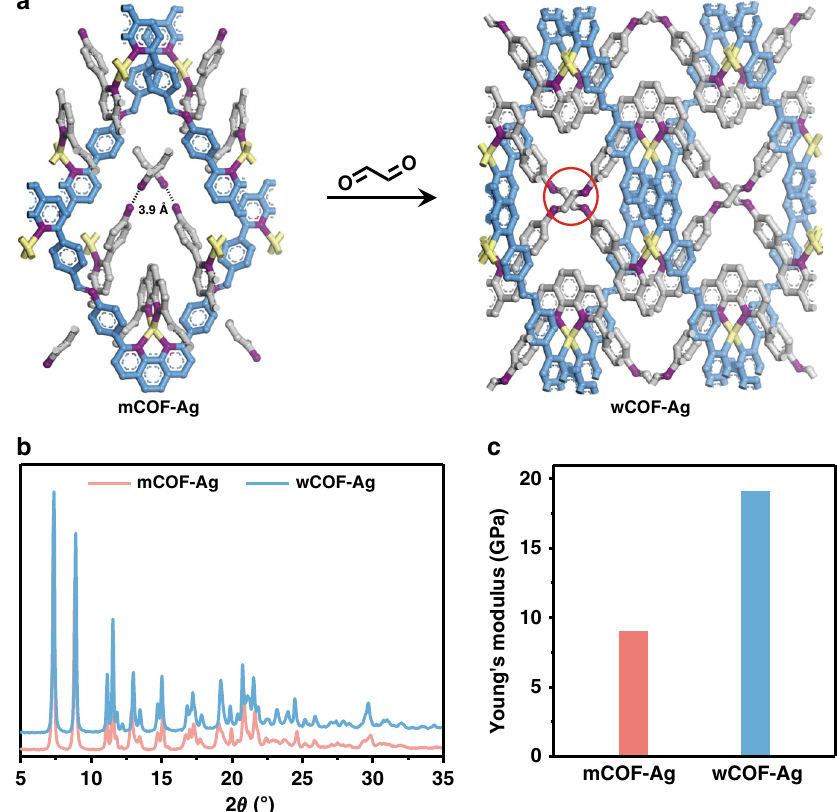
Fig. 4 Crystalline-state polymerisation and characterisation. a Con fi ned environments of mCOF-Ag (left) and the ideal structure of the cross-linked framework, wCOF-Ag (right). One of the cross-linked parts is highlighted with a red circle. Colour scheme: C on organic chains, blue; C on pendants, grey; N, purple; Ag, yellow. Hydrogen atoms and BF 4 ‾ anions are omitted for clarity. b PXRD patterns of mCOF-Ag and wCOF-Ag. c The Young ’ s moduli of mCOF-Ag and